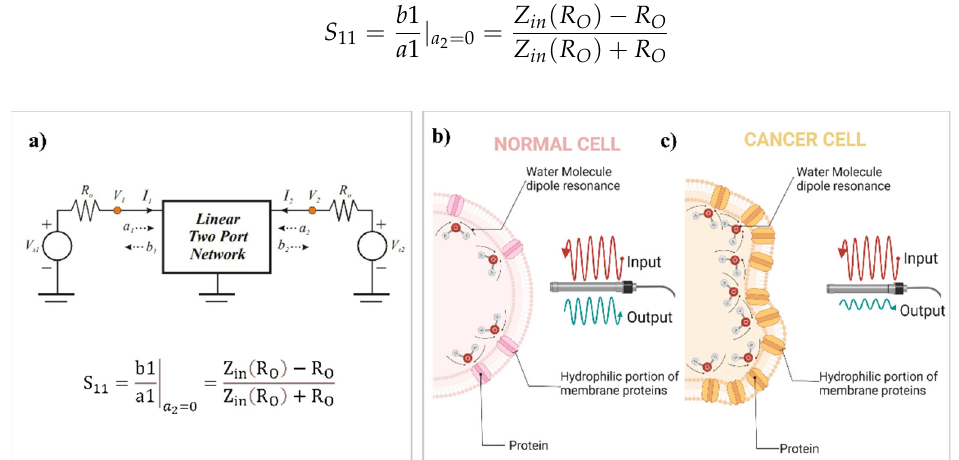
Figure 5. ( a ) Schematic view of an electrical network with two ports in a high-frequency region to describe scattering parameter, S 11 . ( b ) Schematic view of protein content and water distribution of a normal cell, which results in an increased S 11 parameter in normal tissue due to less resonant membrane-bound waters associated with decreased expression of membrane proteins. ( c ) Schematic view of protein content and water distribution of a cancer cell, which results in a decreased S 11 pa- rameter in cancerous tissue due to more resonant membrane-bound waters associated with increased expression of membrane proteins.